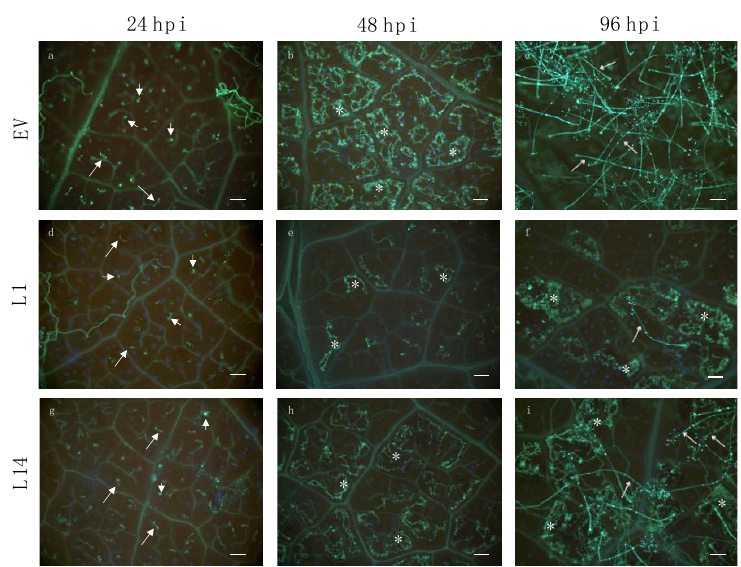
showing that the constitutive expression of VriATL156 induces profound transcriptional reprogramming (Figure 6a; Supplementary Dataset S1).